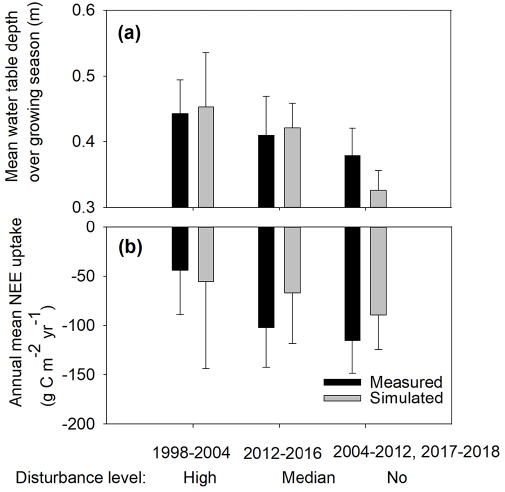
Figure 5. Simulated and measured (a) average mean water table depth over the growing season (May to October), plotted as positive and (b) annual NEE uptake for the different disturbance